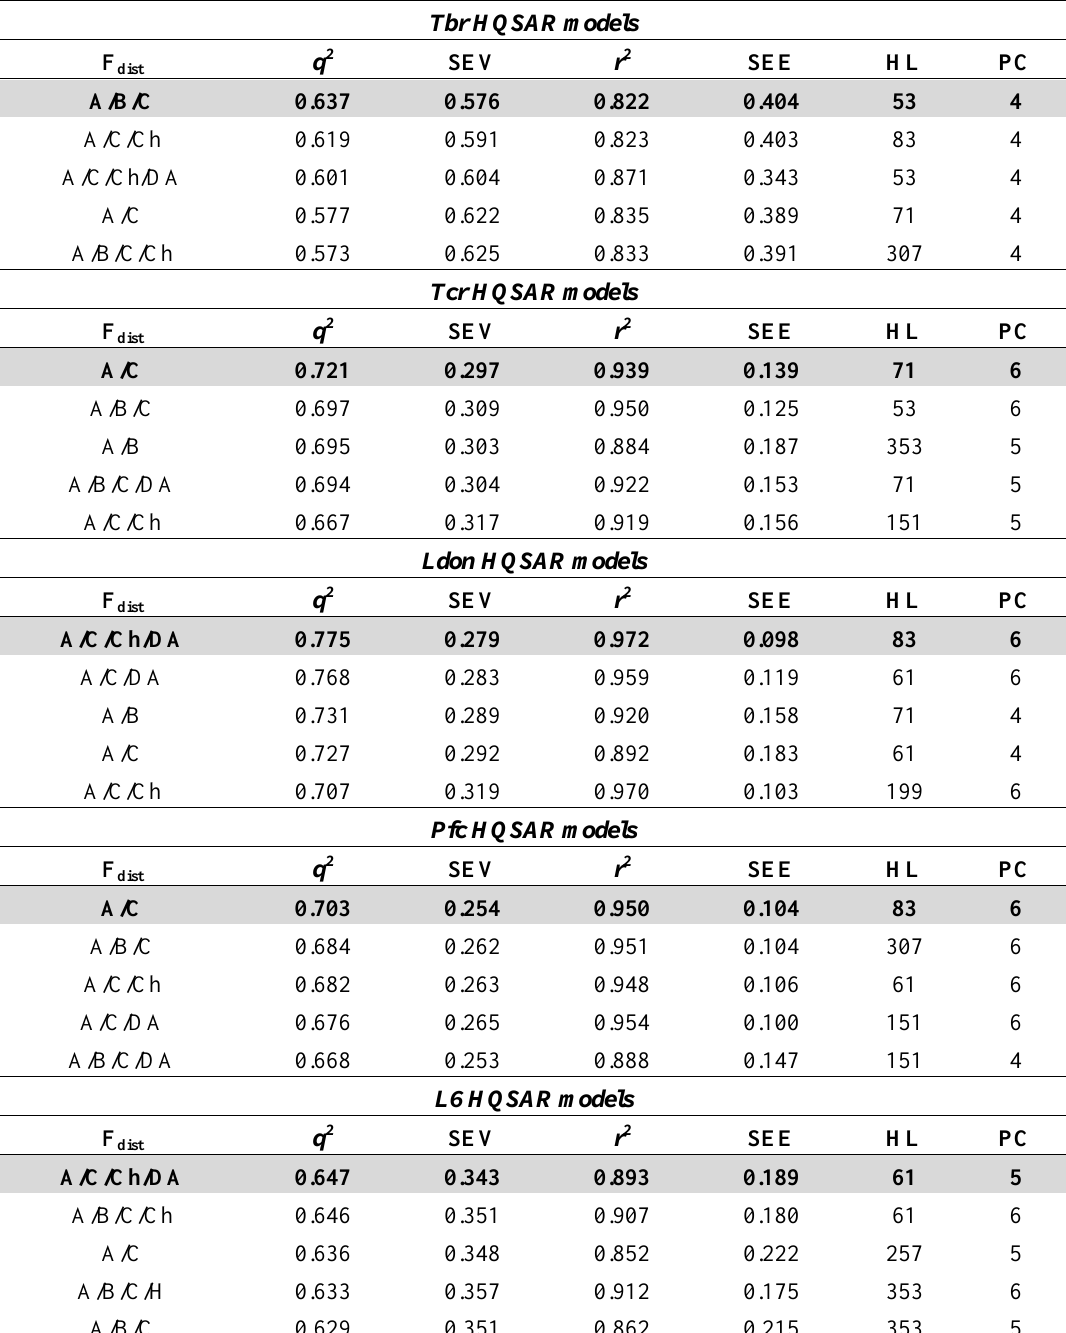
Table 1. 5 Best HQSAR models with fragment size equal to 4 to 7